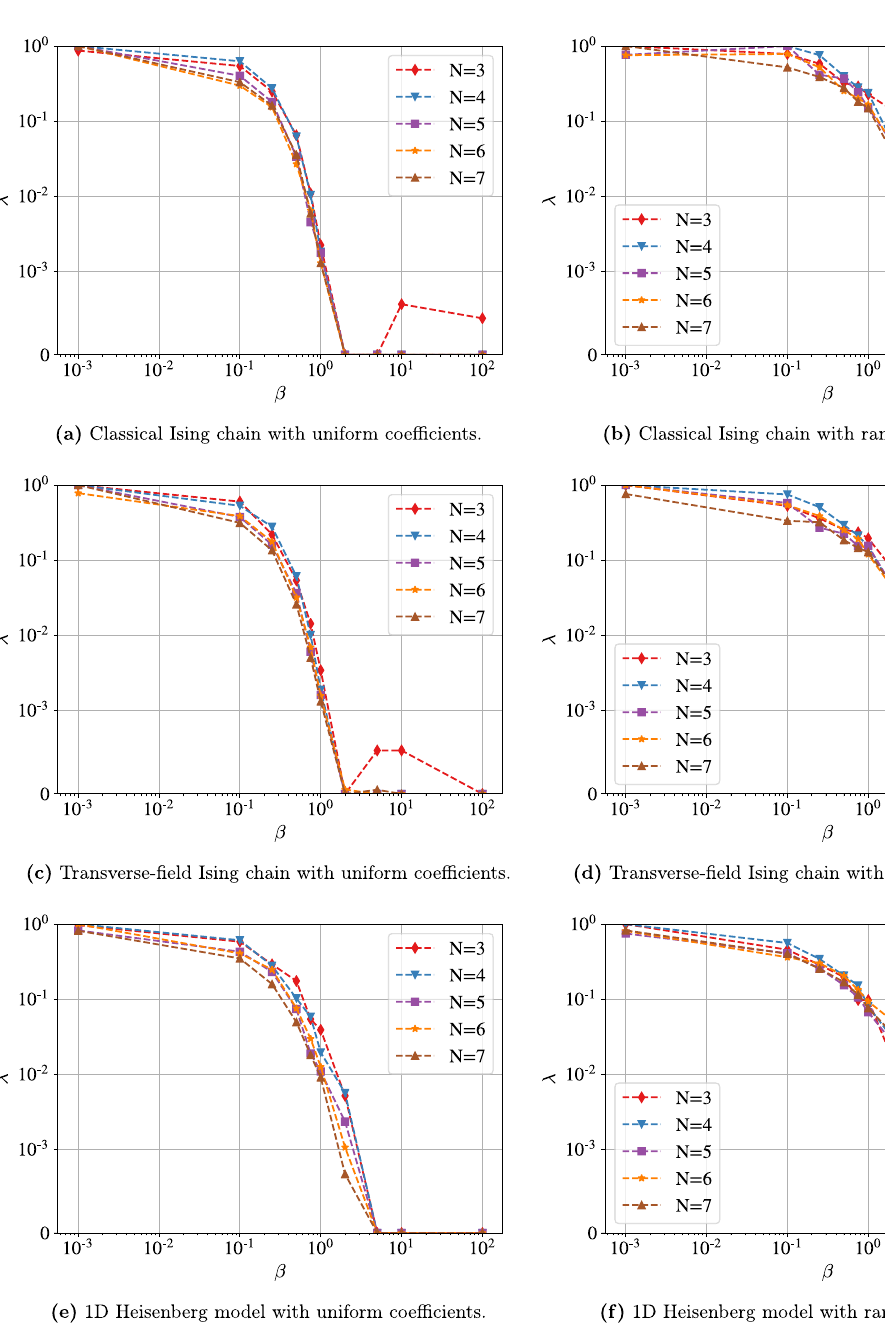
Figure 5. Final noise level (cid:31) as a function of the inverse temperature β for various models and system sizes. We used a symlog scale for the y-axis, hence the scale becomes linear below 10 − 3 1 for β 10 of the noise level with β , with (cid:31) (corresponding to the maximally-mixed state) and (cid:31) − ≈ = 10 2 (corresponding to the ground-state). It shows that the general relationship between the noise and the β ≈ temperature has overall been correctly learned by our